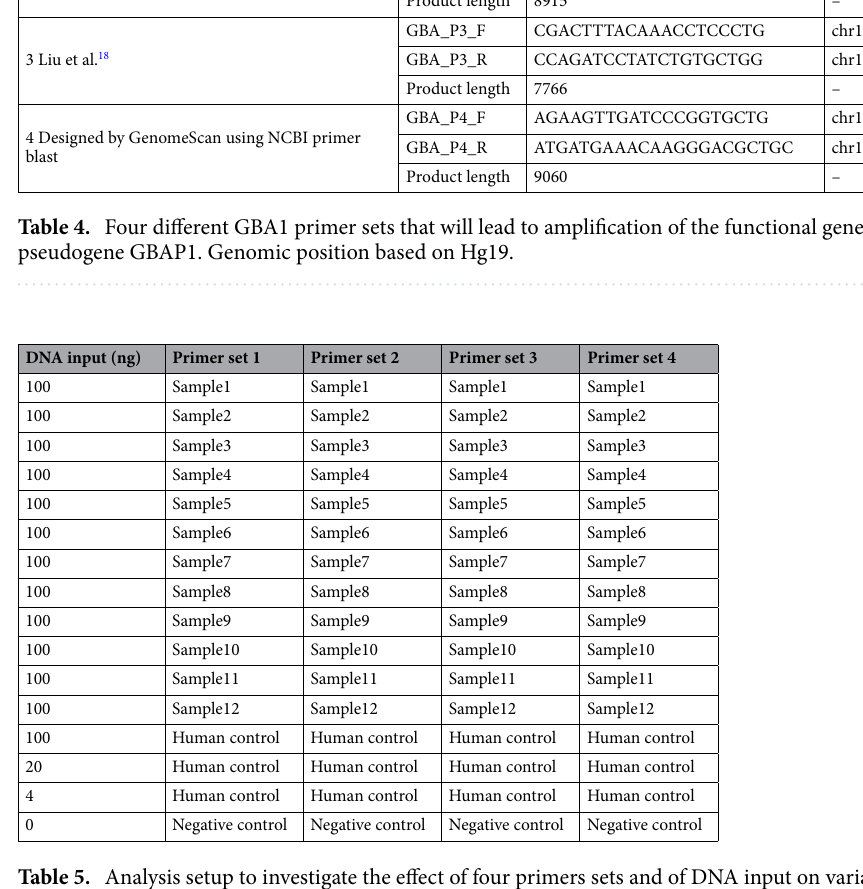
Table 5. Analysis setup to investigate the effect of four primers sets and of DNA input on variant frequencies. This setup was performed once using Q5 polymerase and once using TaKaRa polymerase. Samples one to twelve were previously assessed to have a GBA1 variant using Q5 polymerase, some with abnormal variant frequencies, see Table 3. Negative control samples contained no DNA.